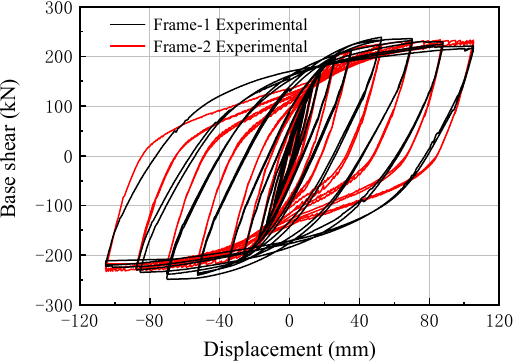
Figure 10. Comparison of hysteresis curves for Frame ‐ 1 test and Frame ‐ 2. At the initial loading stage, Frame ‐ 2 was in the elastic stage. At a positive horizontal displacement of 17.5 mm (0.01 rad), a slight slip rotation of the CPSFCs at the bases of columns was observed; as the loading continued, the slip rotation of the CPSFC became apparent. The test was stopped when the loading reached a negative displacement of 105 mm (0.06 rad). At the end of the loading period, the bearing capacity of Frame ‐ 2 tended to stabilize at 230.2 kN. For Frame ‐ 2, by the end of the test, it was evident that the cover plate at the flange had deformed significantly in bending and the column itself was not buckled, deformed, or damaged. The brass shims between the cover plates and columns were visibly worn. The comparative tests of Frame ‐ 1 and Frame ‐ 2 showed that the seismic performance of the steel frame structure with the CPSFC at the column bases was perfect and the damage was concentrated at the friction cover plates. The CPSFC can greatly re ‐ duce buckling damage to the columns and result in low or no damage to the main struc ‐ ture. The hysteresis curve of specimen Frame ‐ 2 had a slight “pinching” phenomenon; the frictional energy consumption of the column bases was stable and the positive and nega ‐ tive hysteresis curves showed good symmetry.